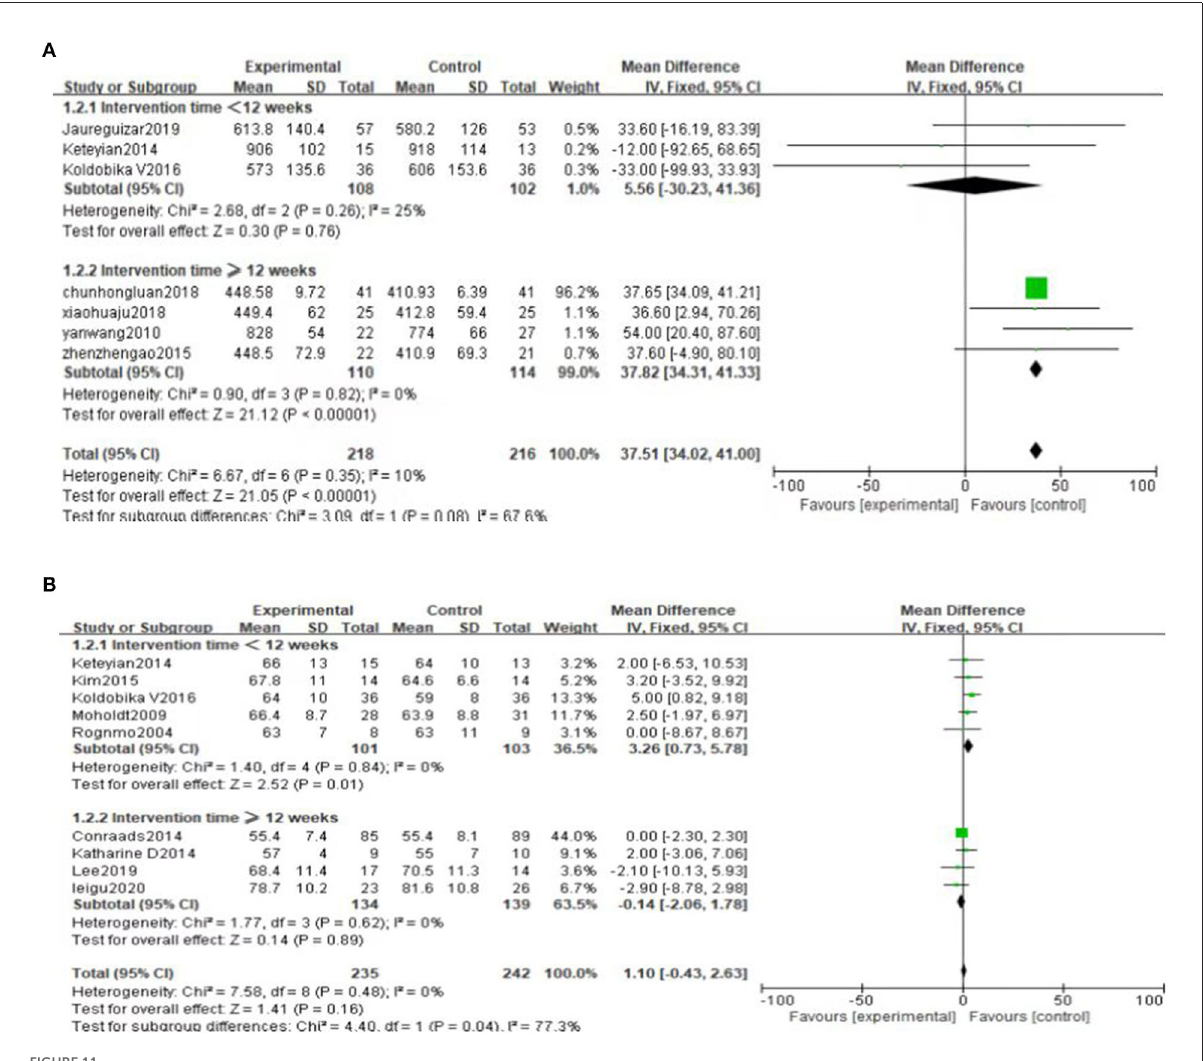
FIGURE11 (A) Subgroup analysis of ED. (B) Subgroup analysis of